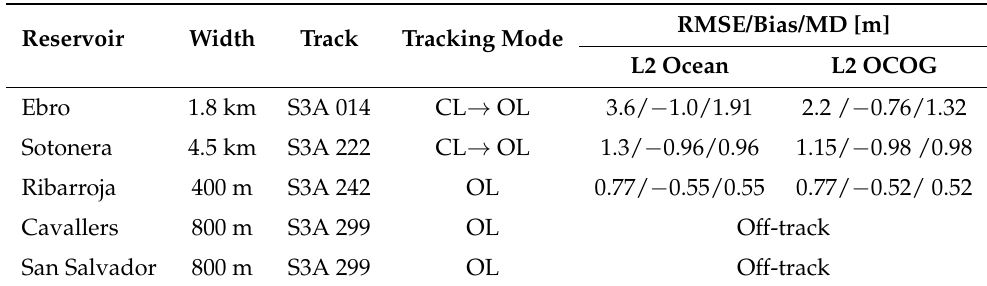
Table 5. Results of the water level comparison with in situ data over the S3A long term monitored reservoirs (June 2016 –December